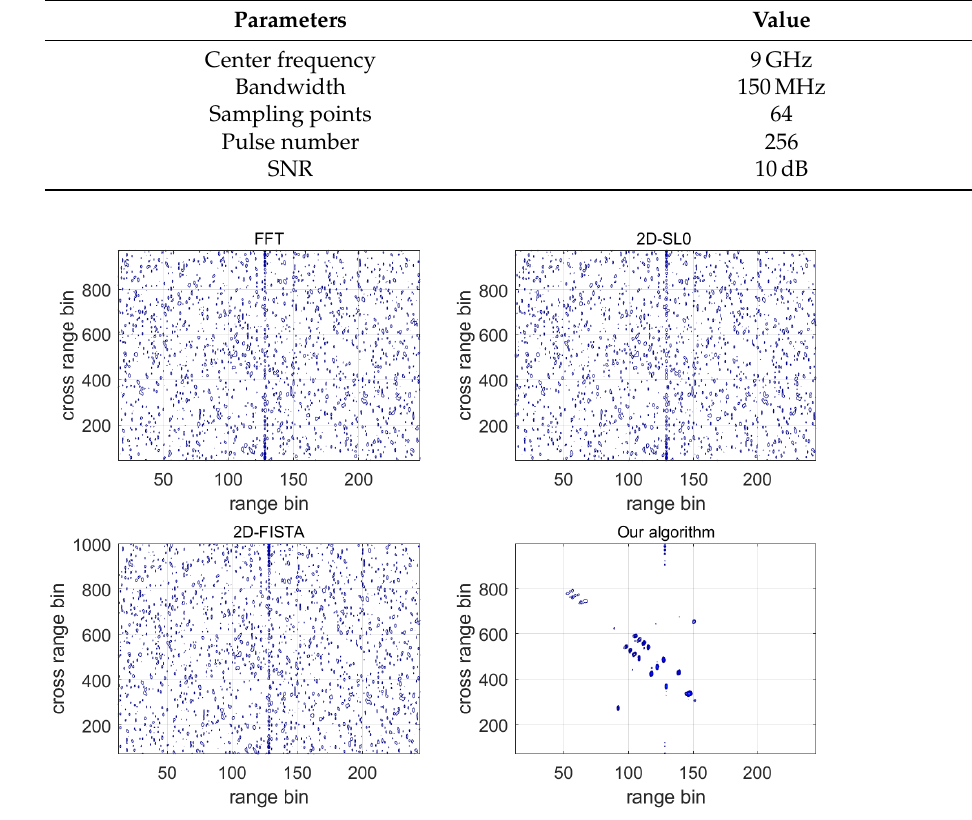
Figure 9. Imaging result with the the percentage of outliers being 39%.